Question: Briefly state, in one sentence, what is plotted here.
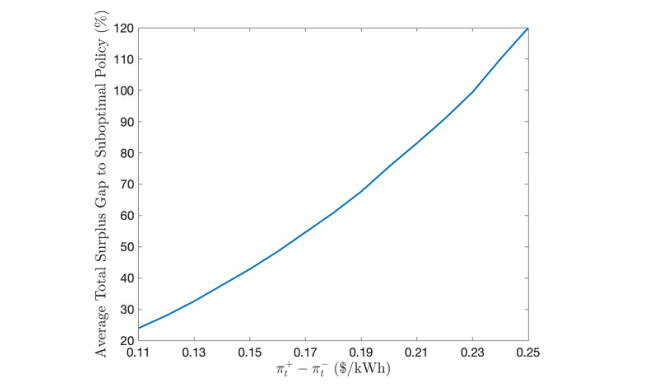
Answer: Impact of π+ t −π− t on the performance of the optimal policy